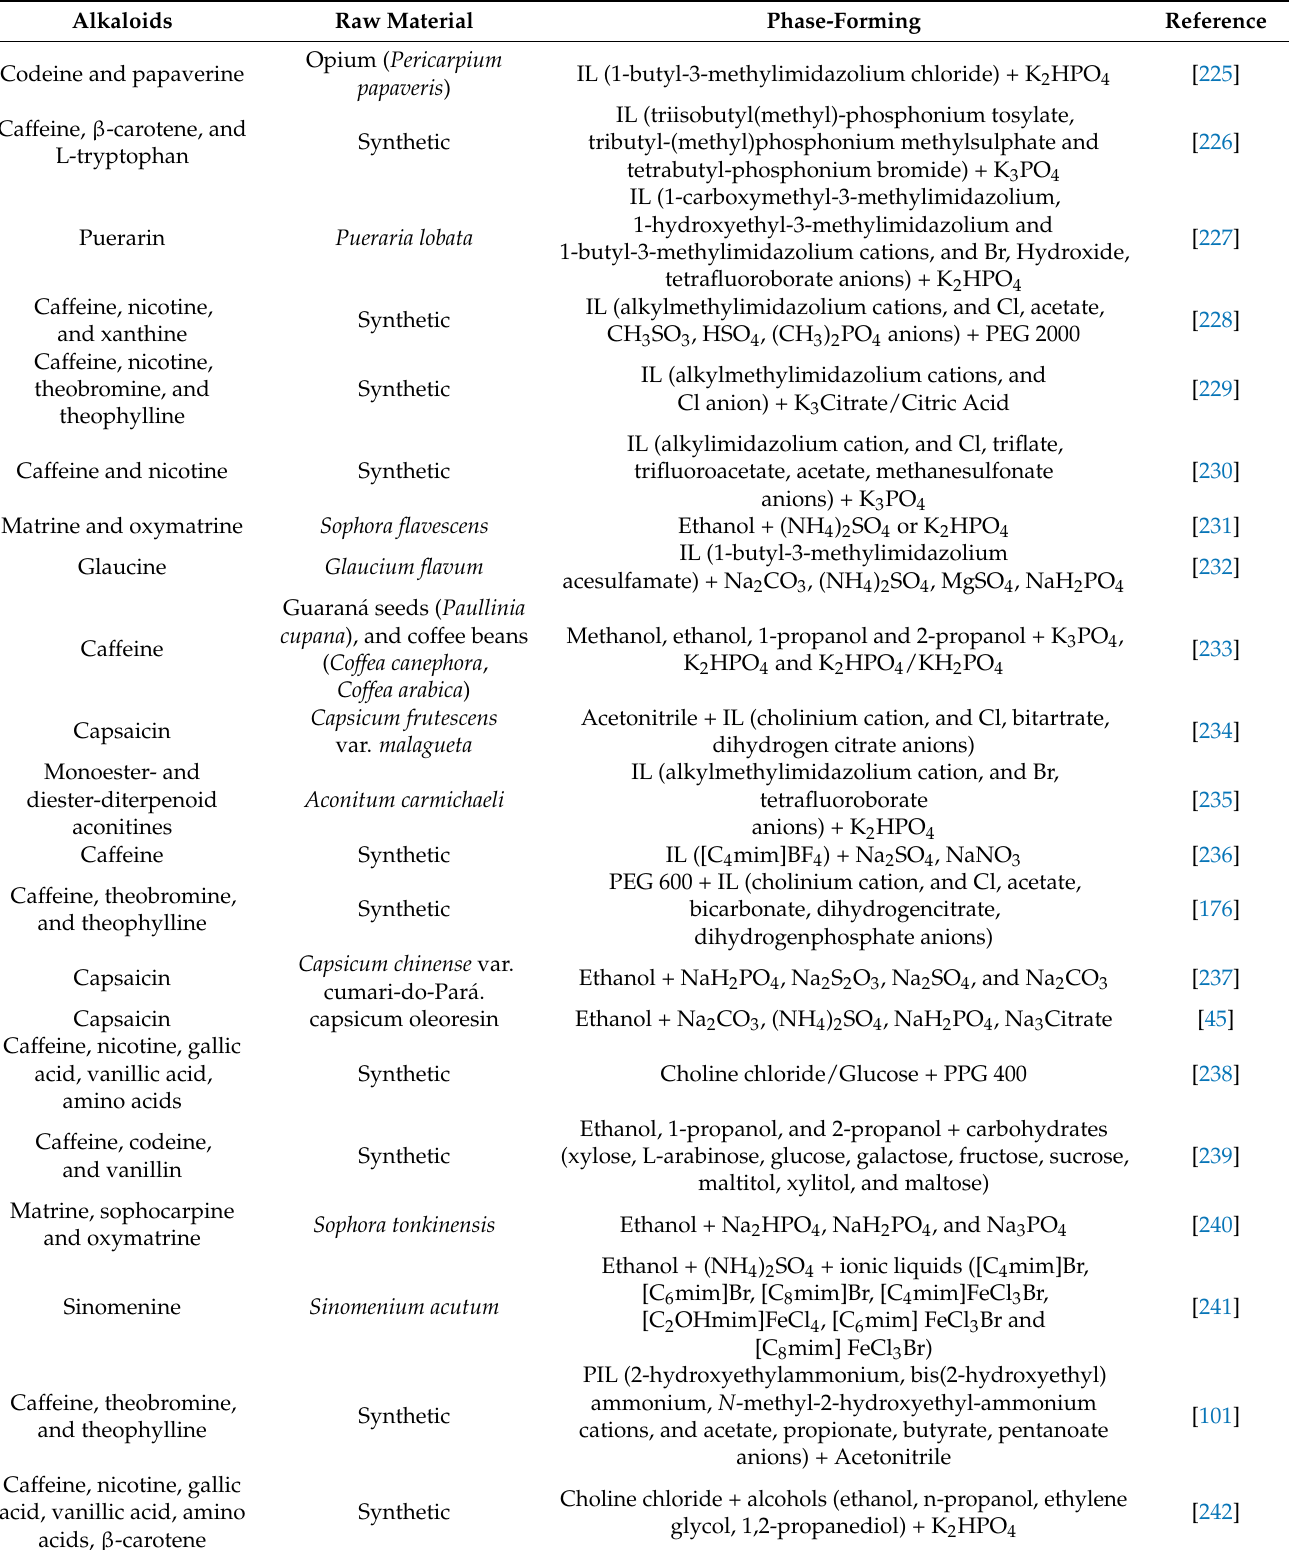
Table 2. Nonconventional ATPS in the extraction and recovery of